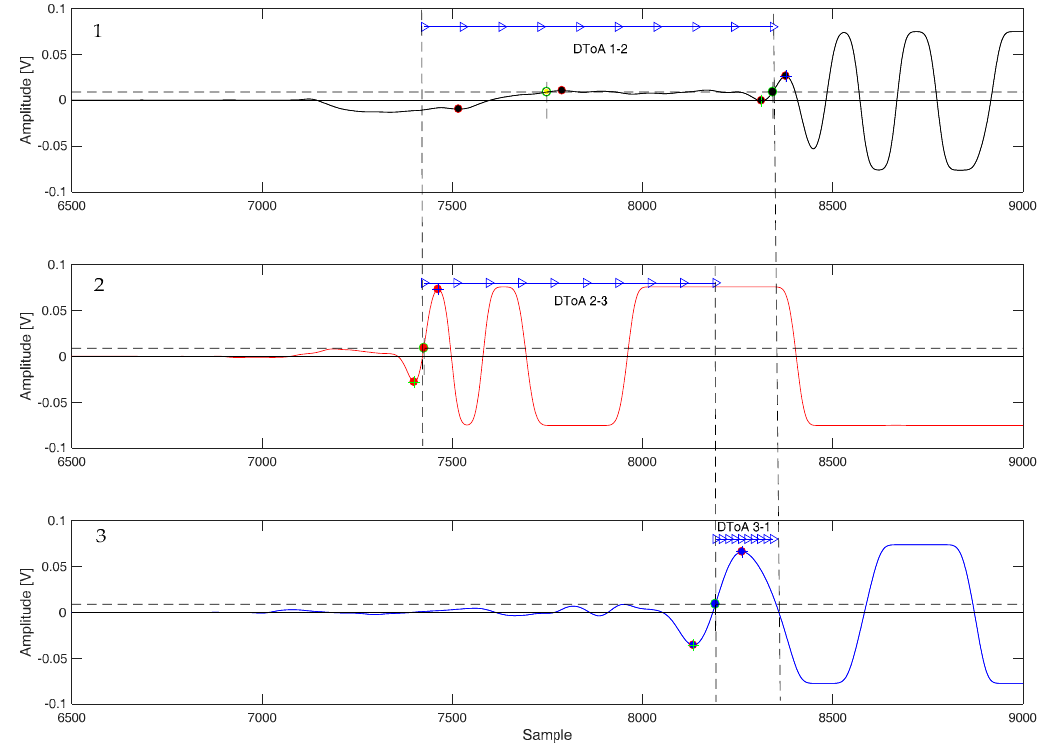
Figure 9. Signals acquired with type B sensors after impact at (170, 110) mm. Sampling rate 10 MSps.